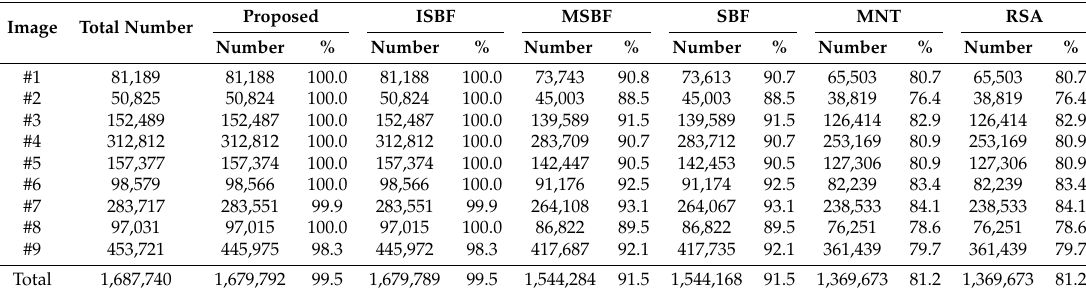
Table 7. Comparison of traced contour pixels.